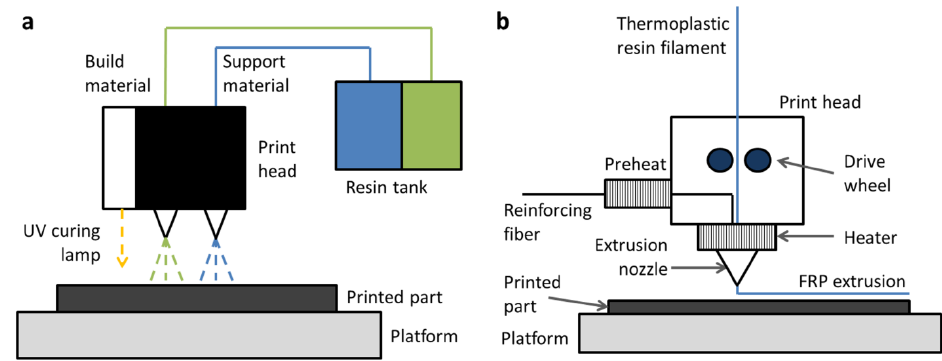
Figure 2. Schematic of additive manufacturing processes for fiber-reinforced polymer composites: ( a ) material jetting and ( b ) fused deposition modeling.